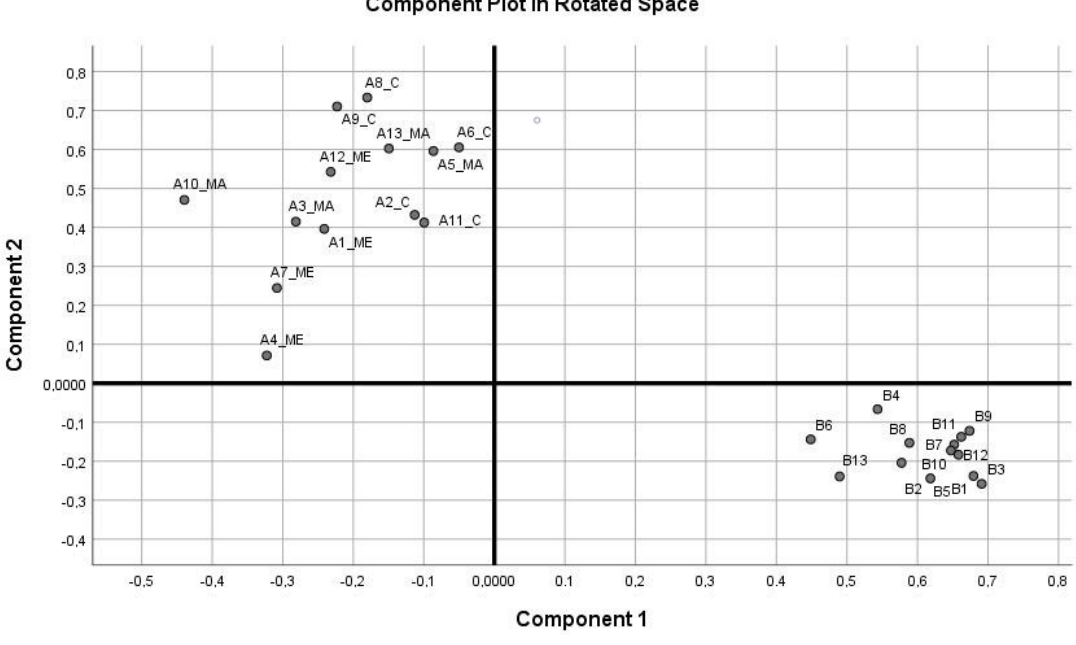
Figure 1. Results of the principal component analysis*.